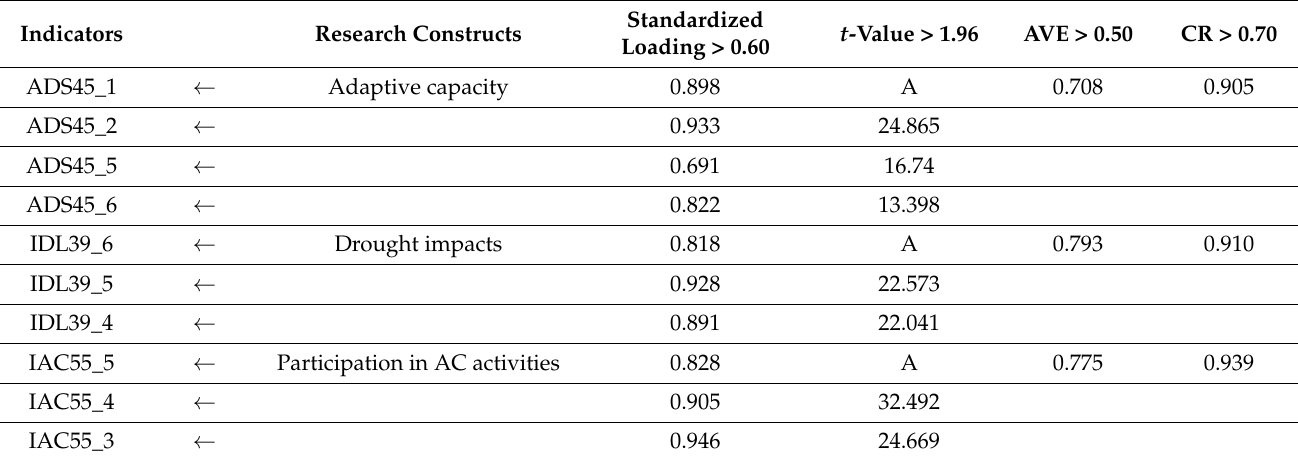
Table 2. The results of the CFA second-order factor